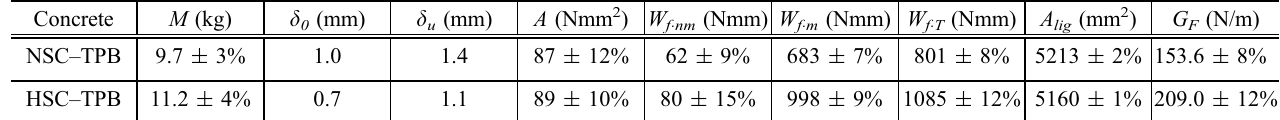
Table 6 Results from TPB tests for NSC and HSC mixes.